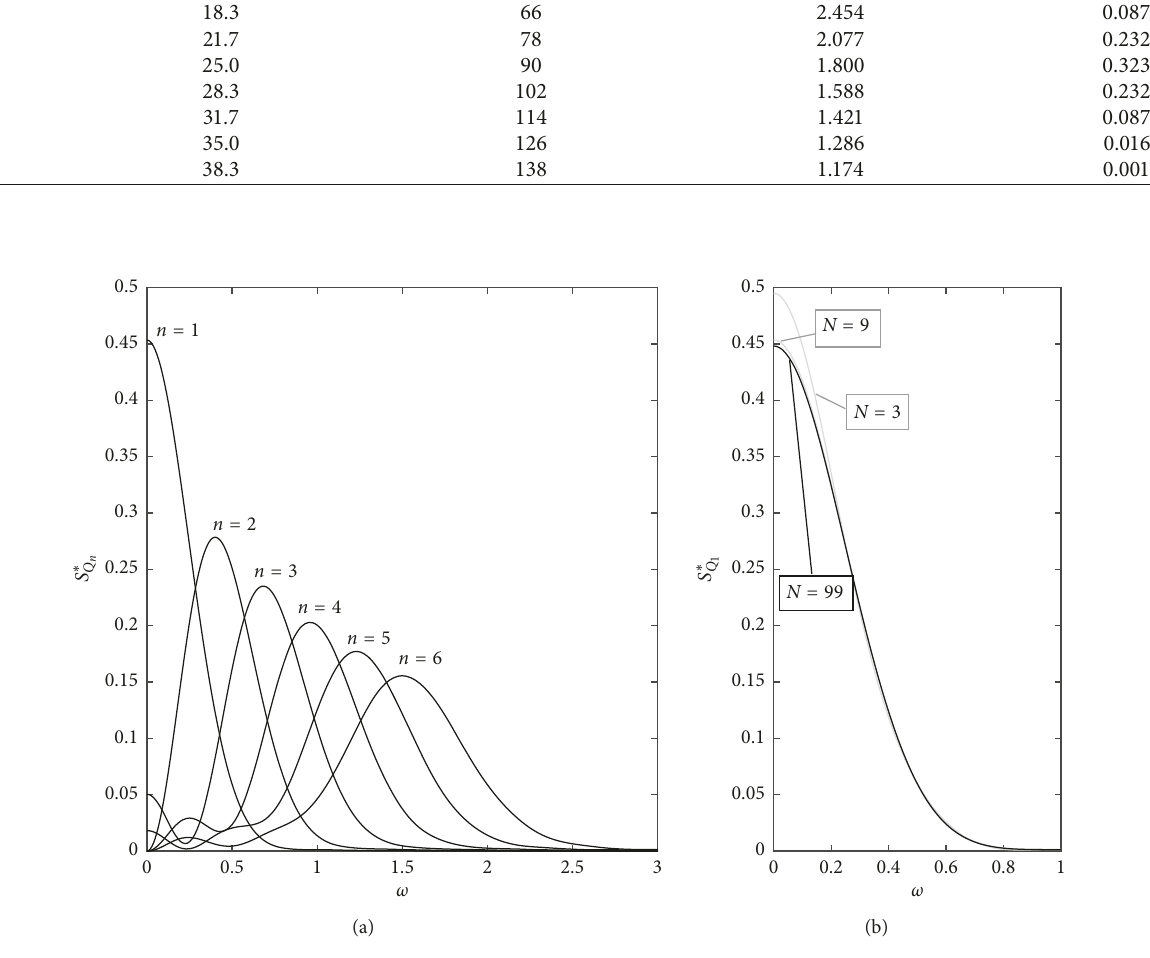
Figure 2: Scaled modal input PSD S ∗ 3 ] (equation (32)) as a function of ω (Hz) for modes n � 1–6 (a) and different discretization values N Q n [s